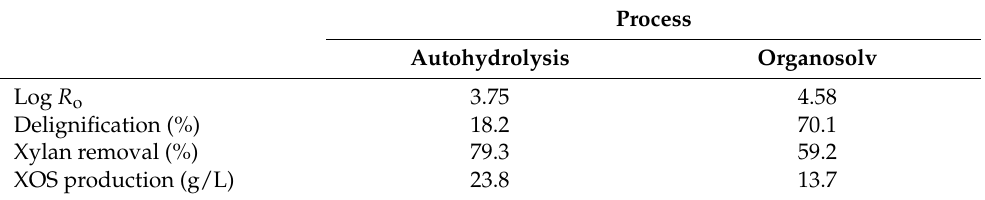
Table 4. Values obtained for Log R O , delignification, xylan removal, and XOS production for autohydrolysis and organosolv treatment after optimization using the Solver function.